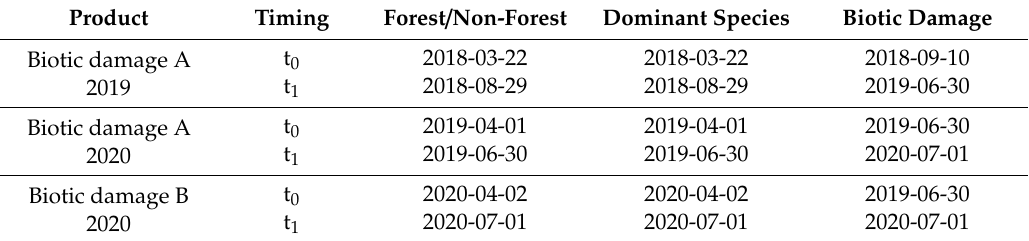
Figure 7. General workflow to obtain bark beetle damage from Sentinel-2 images. Table 2. Sentinel-2 images used to produce each classification map.